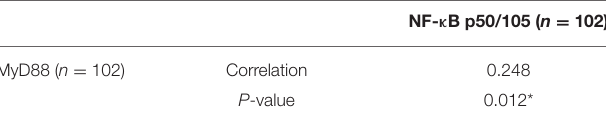
TABLE 2 | Correlation of MyD88 and NF- κ B p50/105 expression in gastric cardia cancer